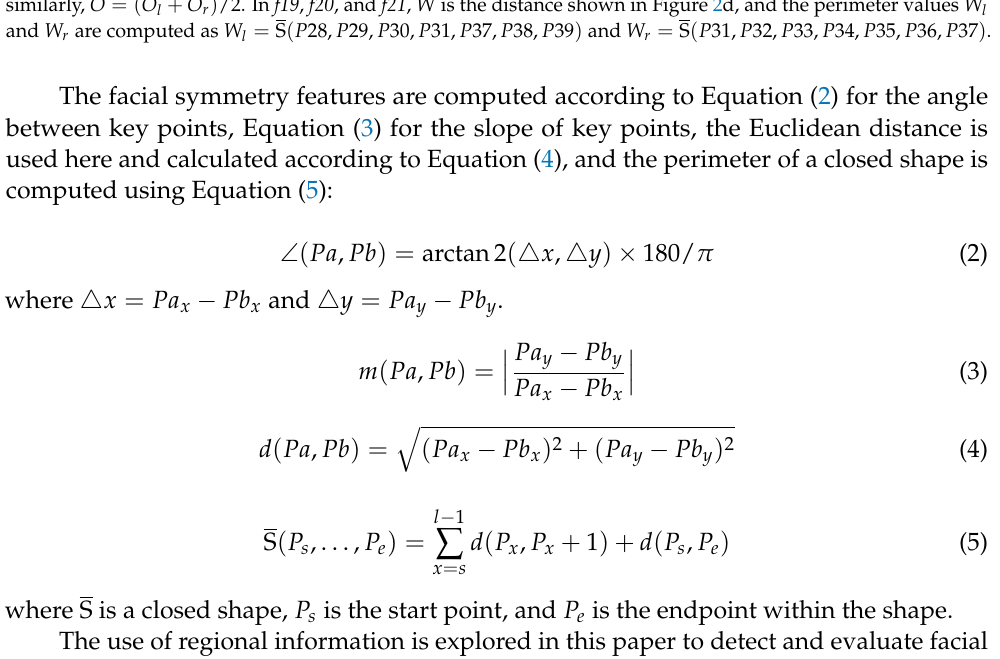
Table 1. Facial symmetry features, introduced by Parra-Dominguez et al. [6]. No. Facial Region Type Formula f0 Eyebrows Angle | ∠ ( P 0, P 9 ) | f1 Eyebrows Angle | ∠ ( P 2, P 7 ) | f2 Eyebrows Angle | ∠ ( P 4, P 5 ) | f3 Eyebrows Max. max ( L / M , M / L ) f4 Eyebrows Slope m ( P 0, P 9 ) f5 Eyebrows Slope m ( P 2, P 7 ) f6 Eyebrows Slope m ( P 4, P 5 ) f7 Eyes Angle | ∠ ( P 10, P 19 ) | f8 Eyes Max. max ( B l / B r , B r / B l ) f9 Eyes Max. max ( D / E , E / D ) f10 Eyes Max. max ( H / I , I / H ) f11 Eyes Max. max ( N / O , O / N ) f12 Eyes Max. max ( N l / O r , O r / N l ) f13 Eyes Max. max ( N r / O l , O l / N r ) f14 Mouth Angle | ∠ ( P 28, P 34 ) | f15 Mouth Max. max ( F / G , G / F ) f16 Mouth Max. max ( P l / Q l , Q l / P l ) f17 Mouth Max. max ( P u / Q u , Q u / P u ) f18 Mouth Max. max ( V l / A , V r / A ) f19 Mouth Max. max ( P l / W , Q l / W ) f20 Mouth Max. max ( P u / W , Q u / W ) f21 Mouth Max. max ( W l / W , W r / W ) f22 Nose Angle | ∠ ( P 23, P 27 ) | f23 Combined Angle | ∠ ( P 22, P 37 ) | f24 Combined Max. max ( J / K , K / J ) f25 Combined Max. max ( T / A , U / A ) f26 Combined Max. max ( R / A , S / A ) f27 Combined Ratio C / A f28 Combined Ratio X / A In f3 , L and M are the average height of all the left and right eyebrow points, respectively. In f11 , N = ( N l + N r ) /2, similarly, O = ( O l + O r ) /2. In f19 , f20 , and f21 , W is the distance shown in Figure 2d, and the perimeter values W l and W r are computed as W l = S ( P 28, P 29, P 30, P 31, P 37, P 38, P 39 ) and W r = S ( P 31, P 32, P 33, P 34, P 35, P 36, P 37 )